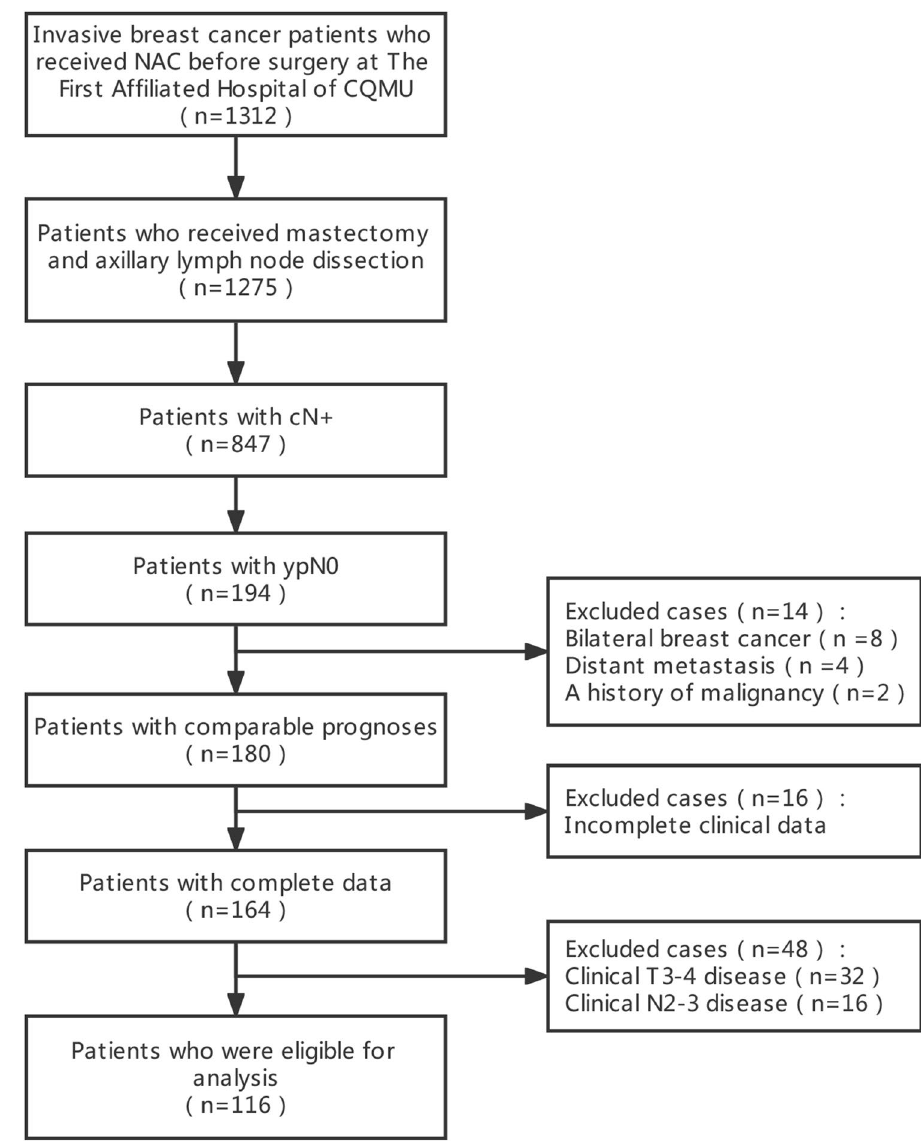
Fig. 1 Flow chart of the patient